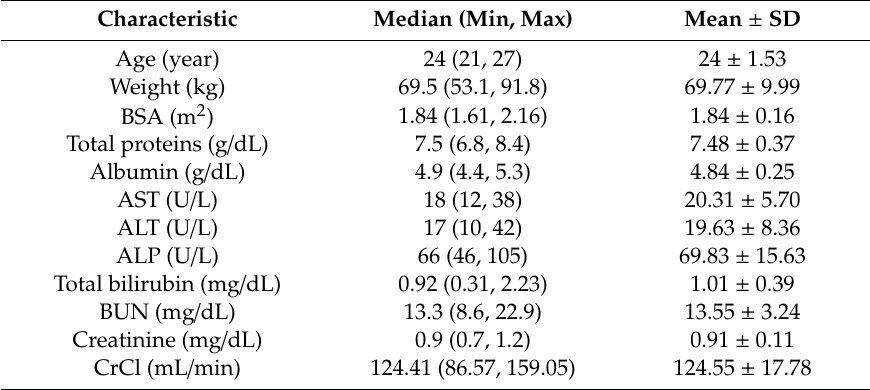
Table 1. Demographical data of subjects ( n =